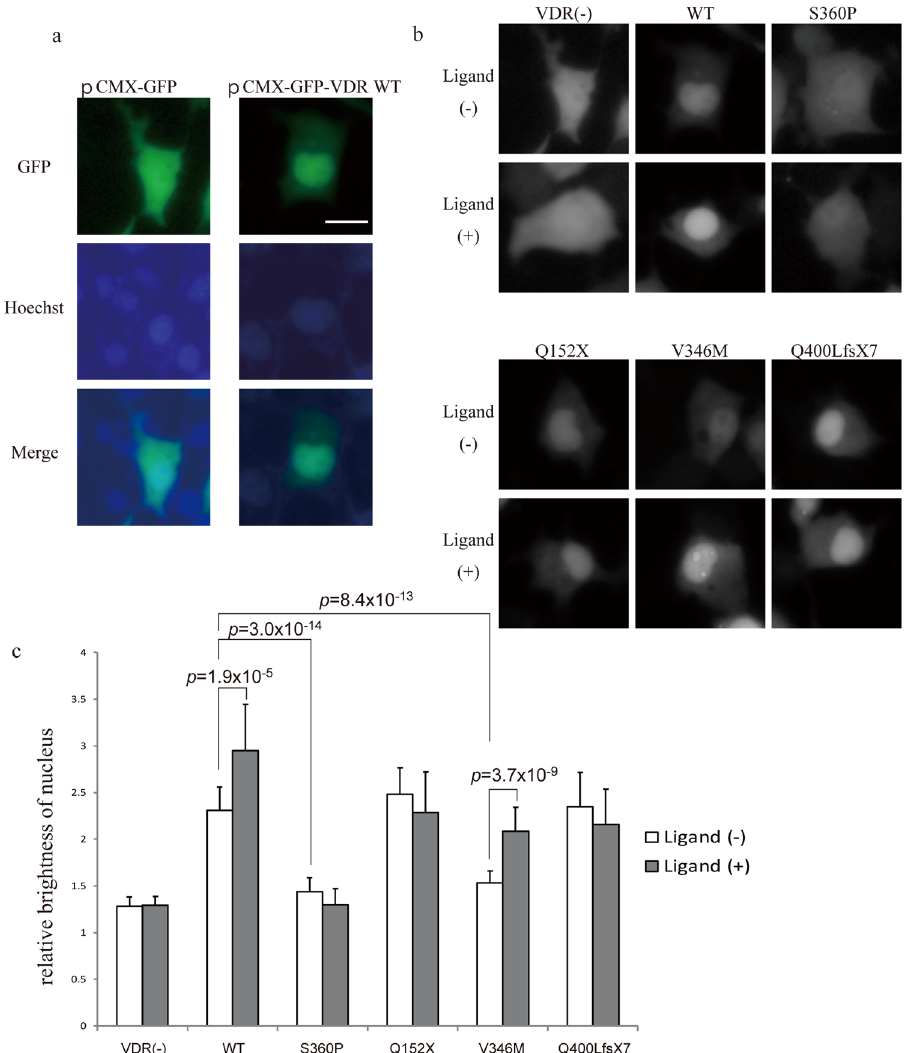
Figure 3. Intracellular localization of wild-type and mutant VDR. ( a ) Representative image of a COS-1 cell transfected with pCMX-GFP and pCMX-GFP-VDR wild type. GFP is shown in green and Hoechst in blue. pCMX-GFP is distributed in the whole cell, and wild-type VDR is partially localized in the nucleus. Scale bar: 20 µ m ( b ) Representative GFP images of a COS-1 cell transfected with pCMX-GFP, -VDR wild type, and each mutant with and without the ligand. ( c ) The ratio of mean brightness of nucleus and cytoplasm analyzed by Image J. n = 20. Data represent means ± SD. Unpaired two-tailed Student’s t